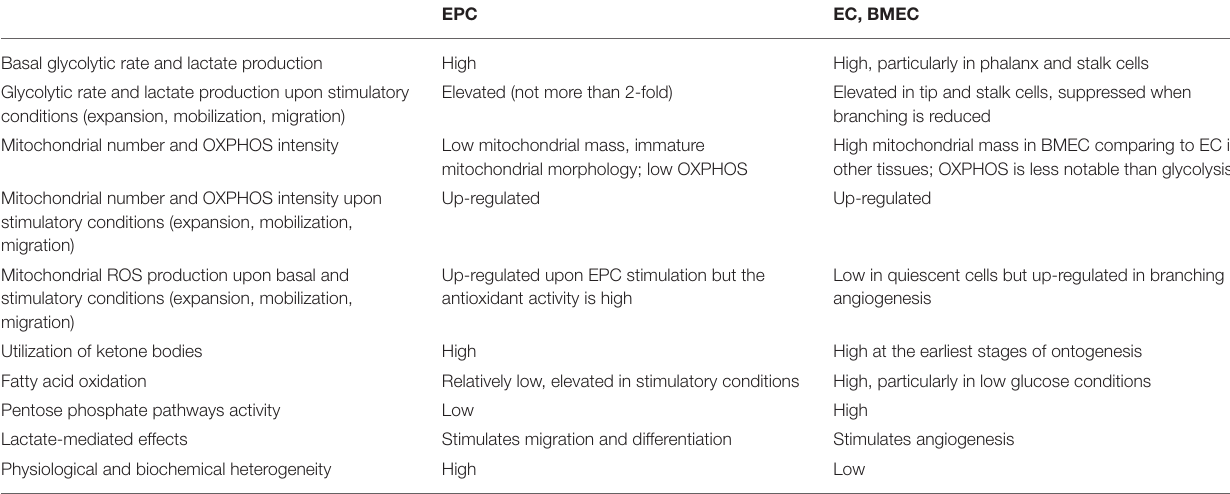
TABLE 1 | Key metabolic properties of EPC, EC/BMEC. EPC EC, BMEC Basal glycolytic rate and lactate production High High, particularly in phalanx and stalk cells Glycolytic rate and lactate production upon stimulatory Elevated (not more than 2-fold) Elevated in tip and stalk cells, suppressed when conditions (expansion, mobilization, migration) branching is reduced Mitochondrial number and OXPHOS intensity Low mitochondrial mass, immature High mitochondrial mass in BMEC comparing to EC in other tissues; OXPHOS is less notable than glycolysis mitochondrial morphology; low OXPHOS Mitochondrial number and OXPHOS intensity upon stimulatory conditions (expansion,